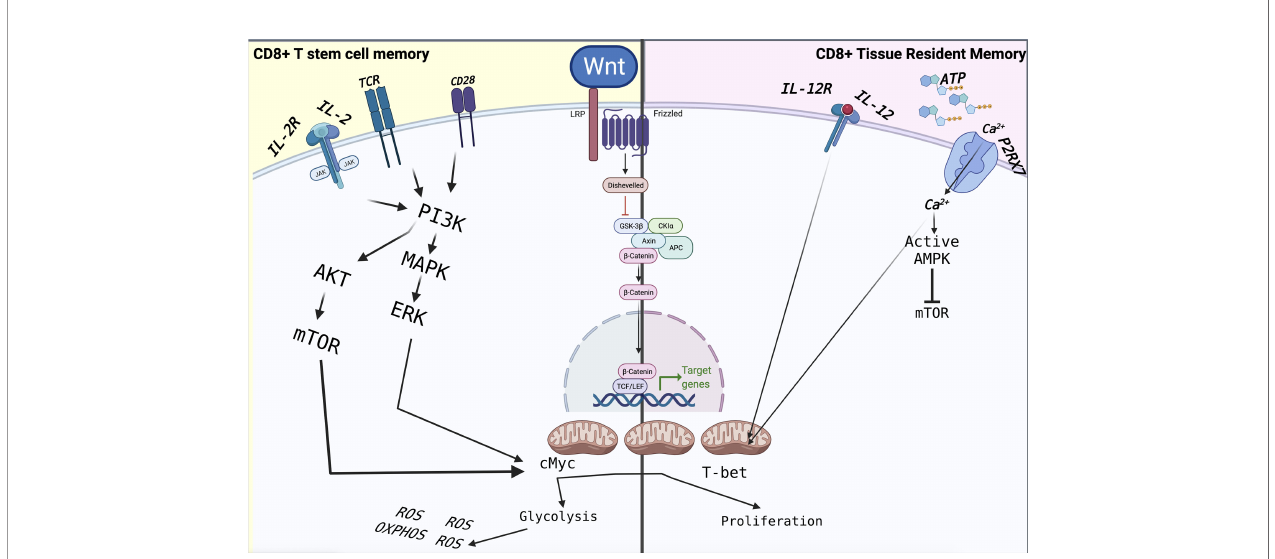
FIGURE 2 | The immunometabolism of T SCM and T RM is driven by extracellular factors, which are mainly based on mitochondrial respiration through FAO for their homeostasis. In particular, the metabolism of TRMs is based on the detection of extracellular ATP mediated by P2XR7, which controls their function and their survival. Following stimulation through TCR and CD28 in the presence of IL-2 and IL-12, CD8 + T cells activate reprogramming, differentiating into effector cells that will lead to the elimination of the pathogen or tumour cell. The signalling pathways are those of MAPK and mTOR, which lead to cell proliferation assisted by intense metabolic activity such as glycolysis and OXPHOS. The latter leads to the increased production of ROS, which will induce terminal differentiation and ultimately apoptosis, limiting the overall antitumor effect of CD8 + T